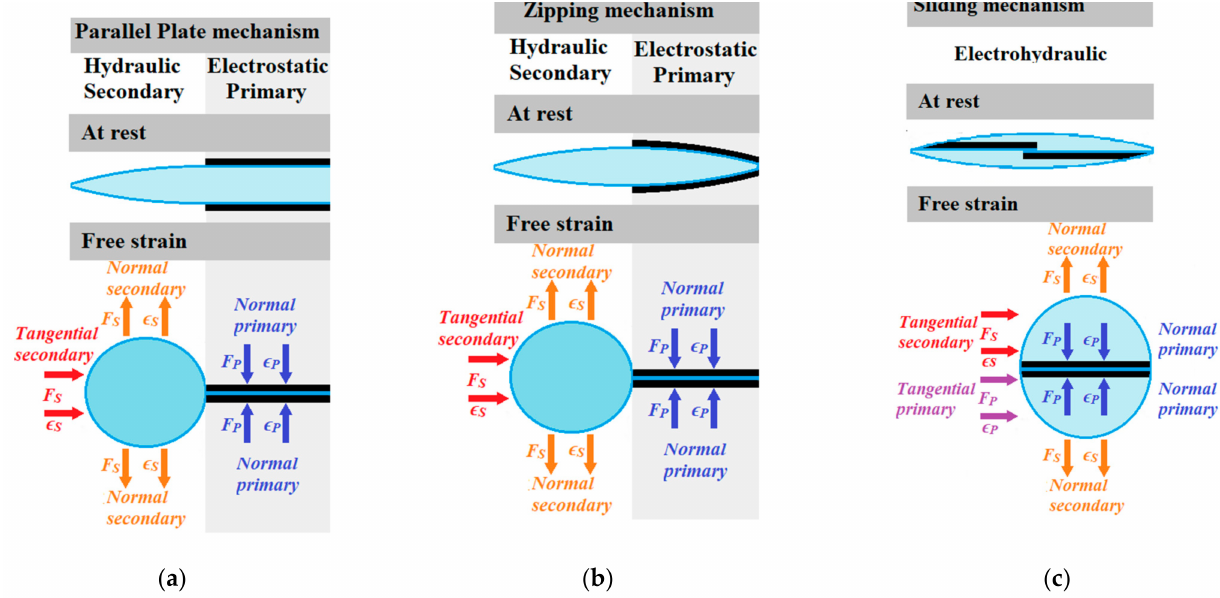
Figure 12. Cross-sectional view of HASEL actuators under no strain or at rest (see top row) and their “free strain” contraction and expansions due to primary electrostatic force-strain ( F p and (cid:101) p ) generation and secondary hydraulic force-strain ( F s and (cid:101) s ) transmission for each mechanism as follows ( a ) the parallel plate mechanism, ( b ) the zipping mehcanism, and ( c ) the sliding